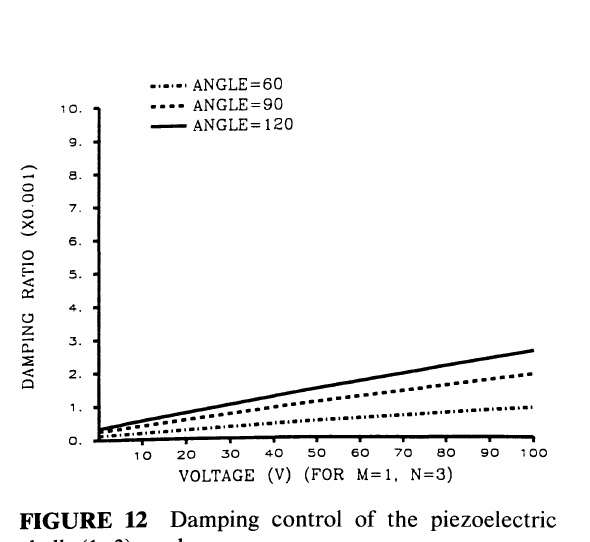
FIGURE 12 Damping control of the piezoelectric shell, (1, 3)